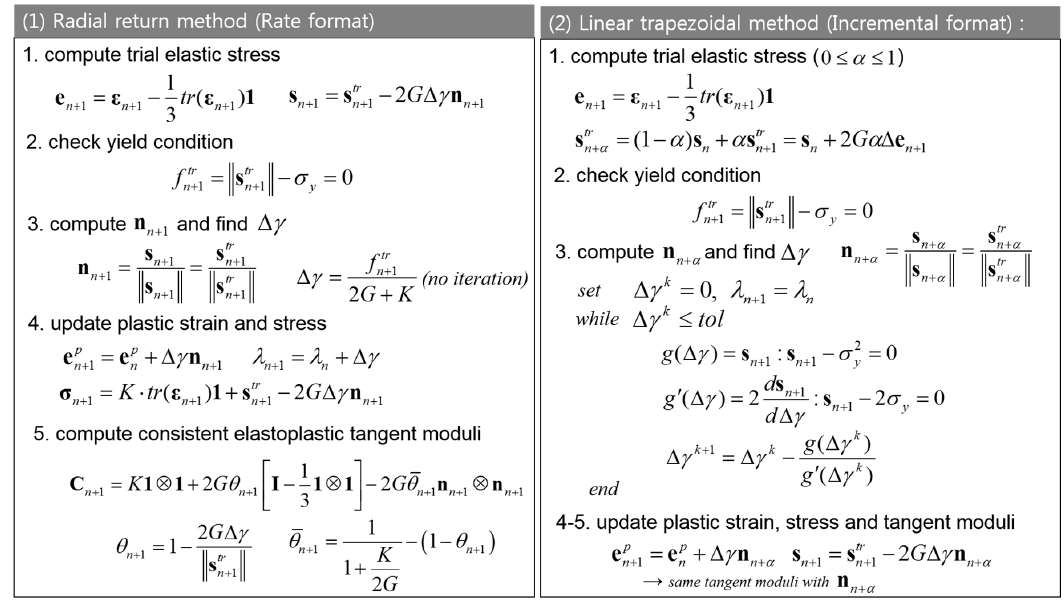
Figure 5. Validation of the linear α -method: ( a ) central difference, 1/ 2 α= ; ( b ) skewed difference, 2 / 3 α= ; and ( c ) backward Euler integration, 1 α= .